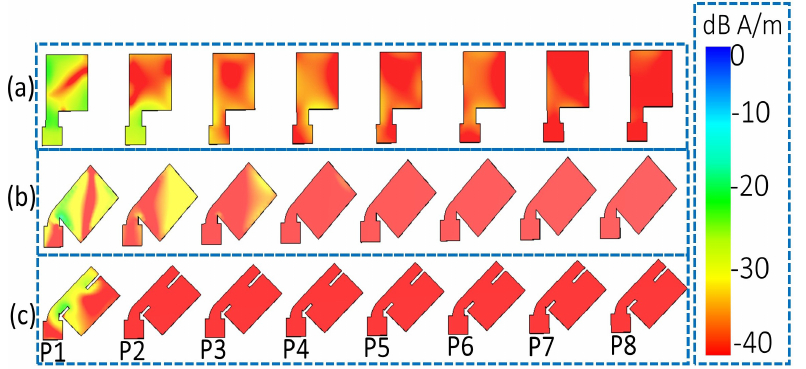
Figure 4. Surface current distribution of ( a ) straight elements, ( b ) bend elements, and ( c ) proposed eight-element MIMO